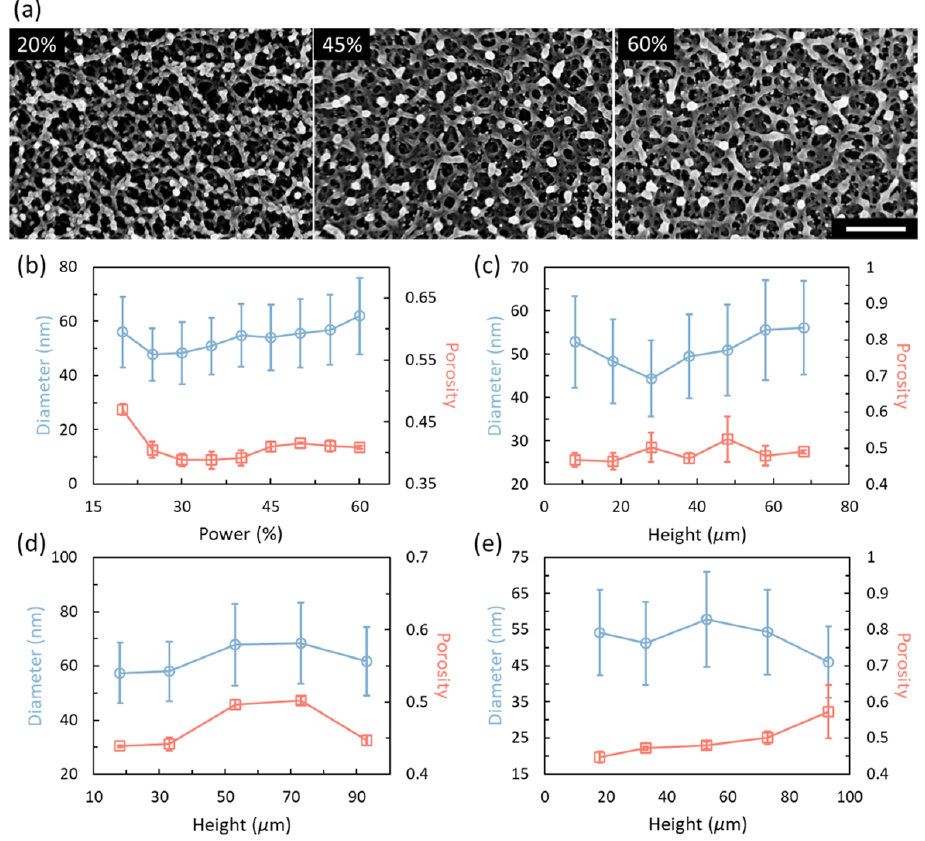
Figure 10. Nanostructure, chain diameter, and porosity of the 4D printed hydrogels. ( a ) Nanostruc- tures of the hydrogel matrix from the standard prints obtained by critical point drying under ethanol. Scale bar: 500 nm. ( b ) Chain diameter and porosity of the standard calibration prints. ( c ) Chain diameter and porosity of samples calibrated for 20% power. ( d ) Chain diameter and porosity of samples calibrated for 30% power. ( e ) Chain diameter and porosity of samples calibrated for 40% power. All data points are obtained based on three samples. The error bars for blue curves are the standard deviation of the distribution of chain